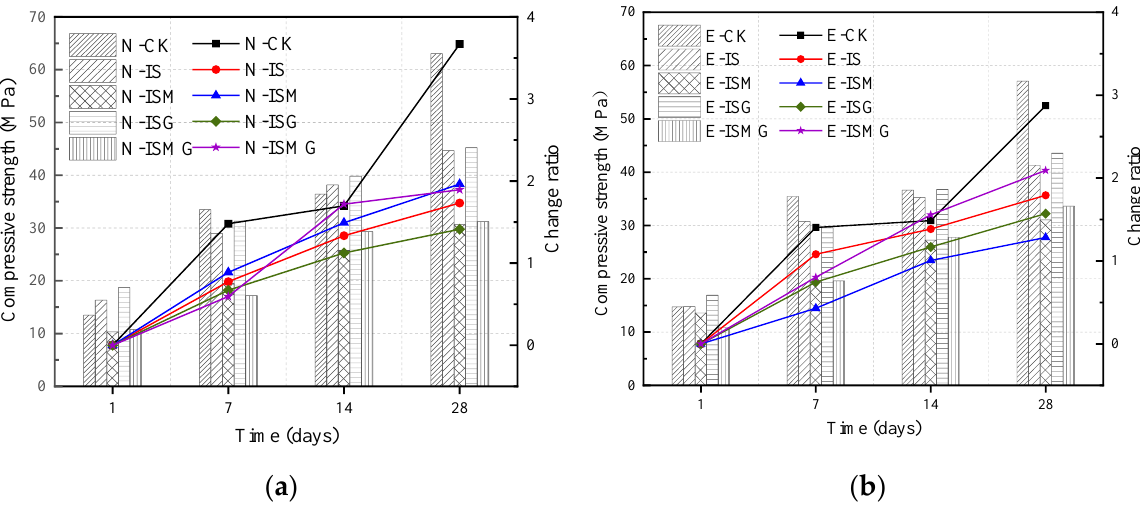
Figure 4. Compressive strength and change ratio of specimens in different stages: ( a ) NC specimens and ( b ) EC specimens.